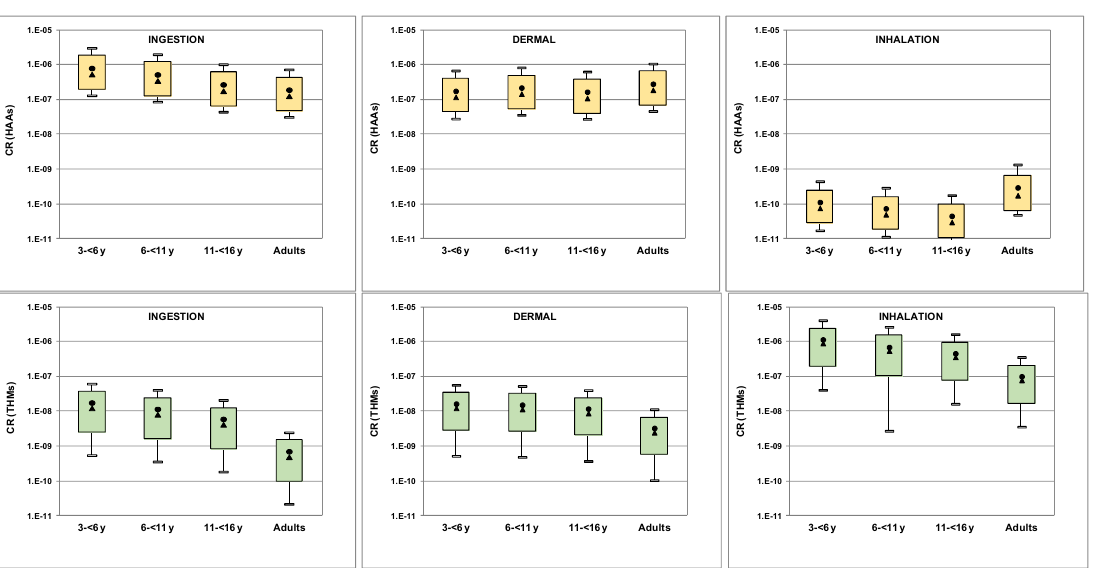
Figure 5. Hazard indices through different exposure routes for THMs and HAAs (boxplots represent 10th and 90th percentiles, min and max values; circle and triangle represent mean and median values, respectively).